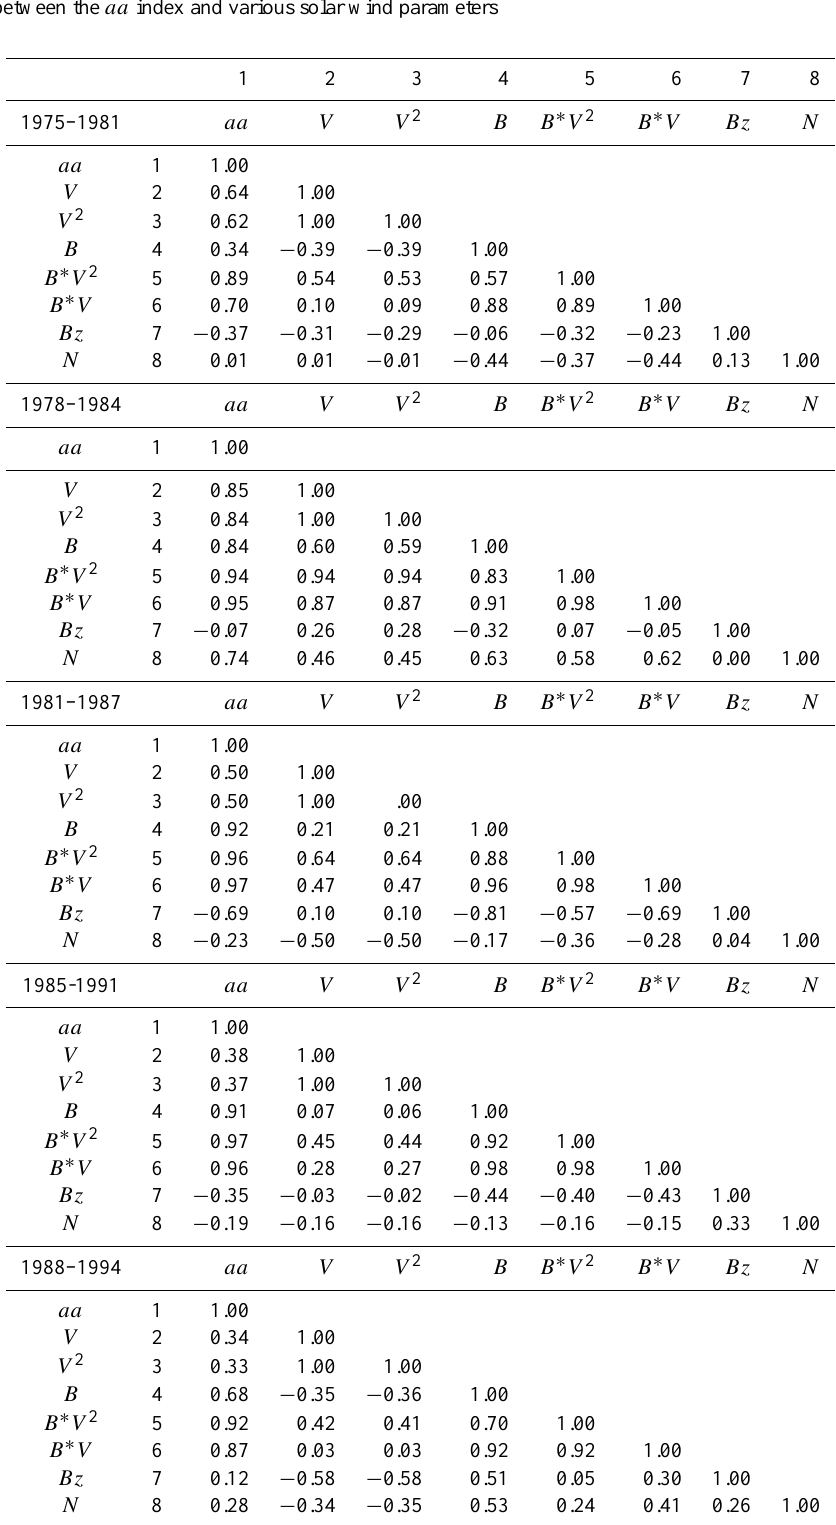
Table 1. Correlations between the aa index and various solar wind